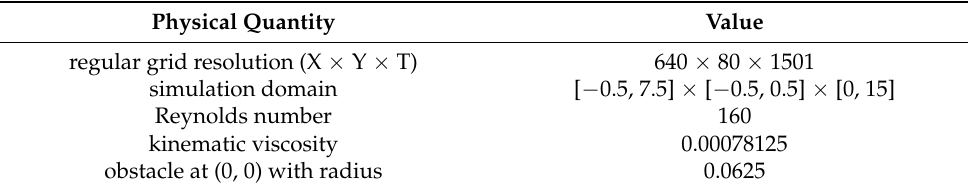
Table 1. Numerical setting (all variables are dimensionless), from